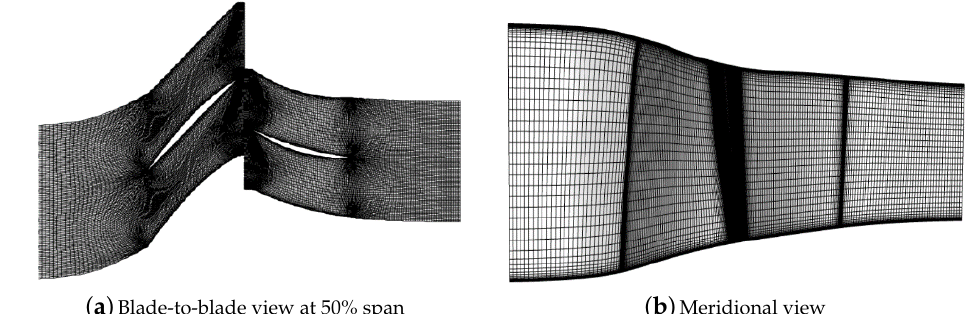
Figure 9. Computational mesh used for the NASA Stage